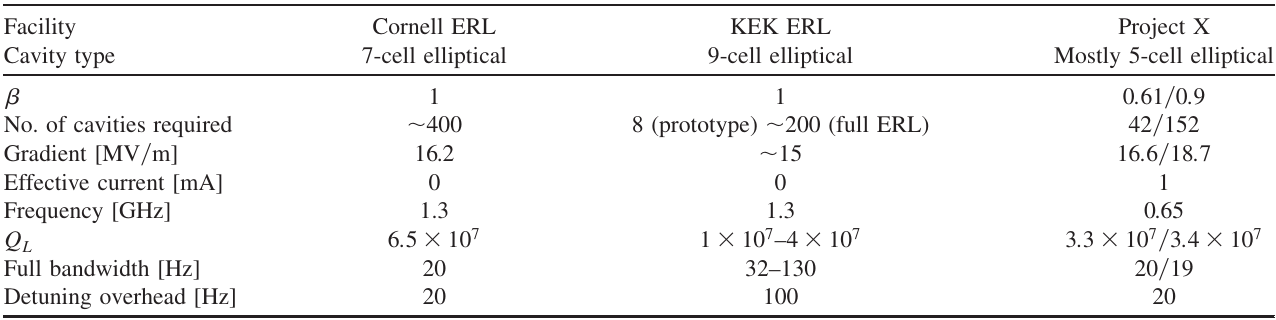
TABLE I. A selection of cw linacs under design with small beam loading. Detuning overhead refers to the maximum detuning that can be tolerated in a cavity at the design gradient before running out of rf power. Data are from